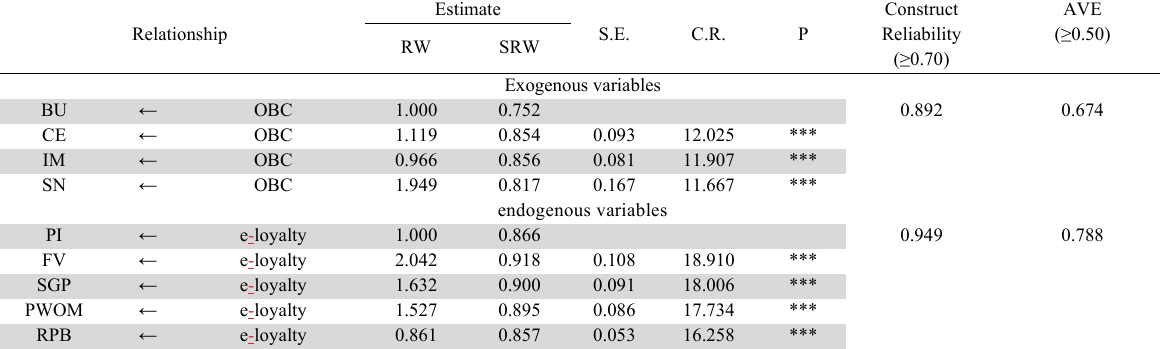
Validity and reliability of constructs